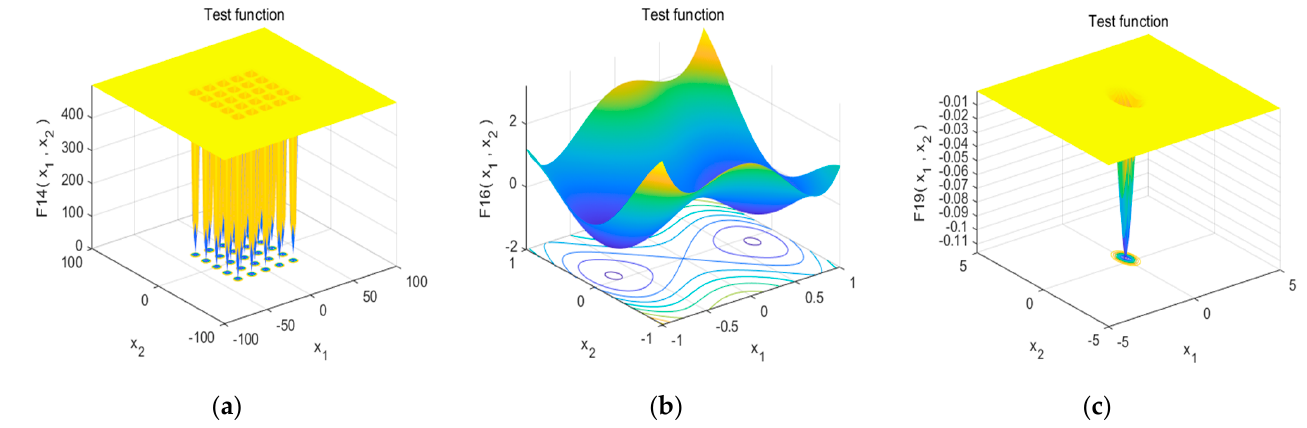
Figure 9. Distribution diagram of different fixed multimodal test function values. ( a ) F14 function; ( b ) F16 function; ( c ) F19 function.